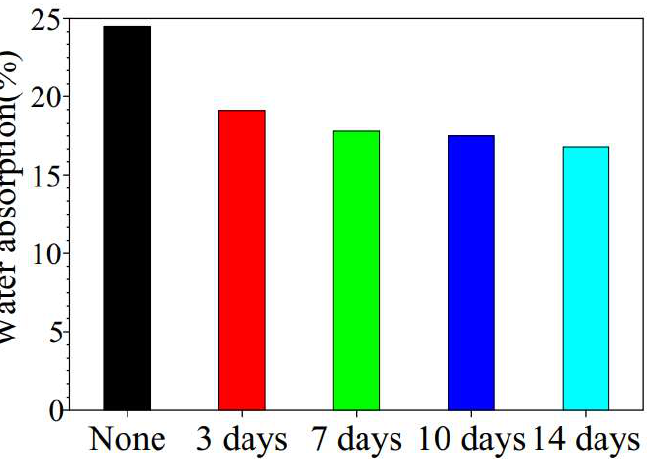
Figure 26. Effect of treatment on water absorption [50]. Reproduced with permission from [50], Elsevier, 2020.